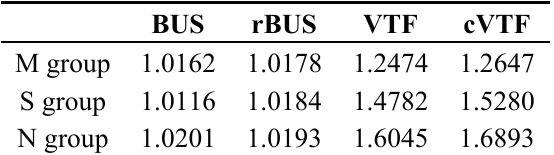
Table 1. Averaged re-contact distance overheads of successful Track-Out activities in the qualitatively analyzed typical